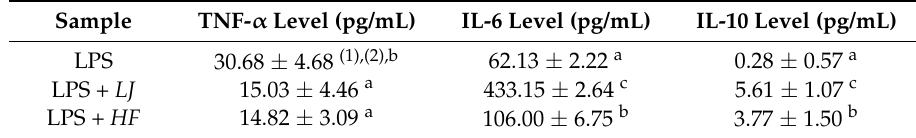
Table 2. Effects of LJ and HF extracts on cytokine production in lipopolysaccharide (LPS)-stimulated C2C12 myotube